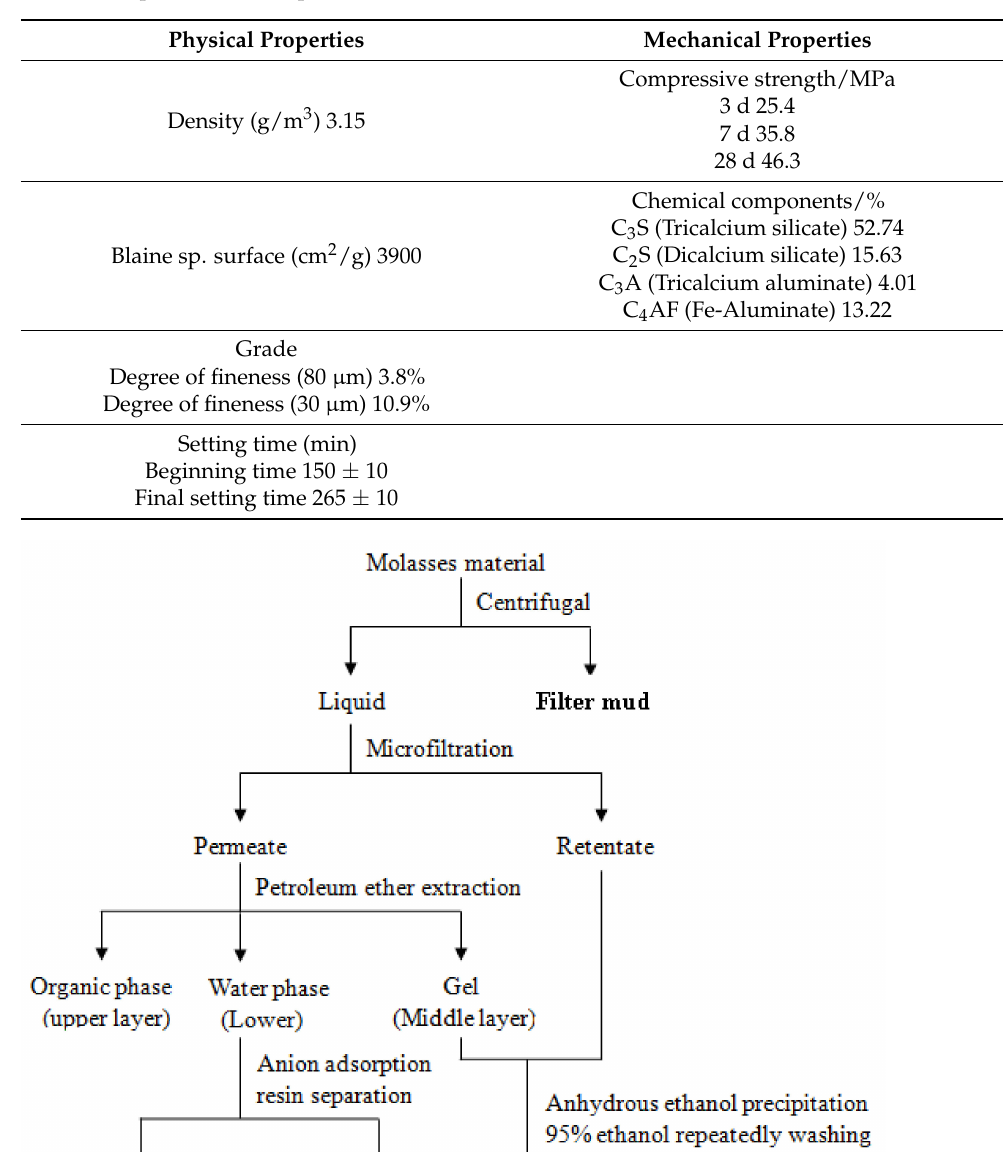
Table 1. Properties and composition of cement.